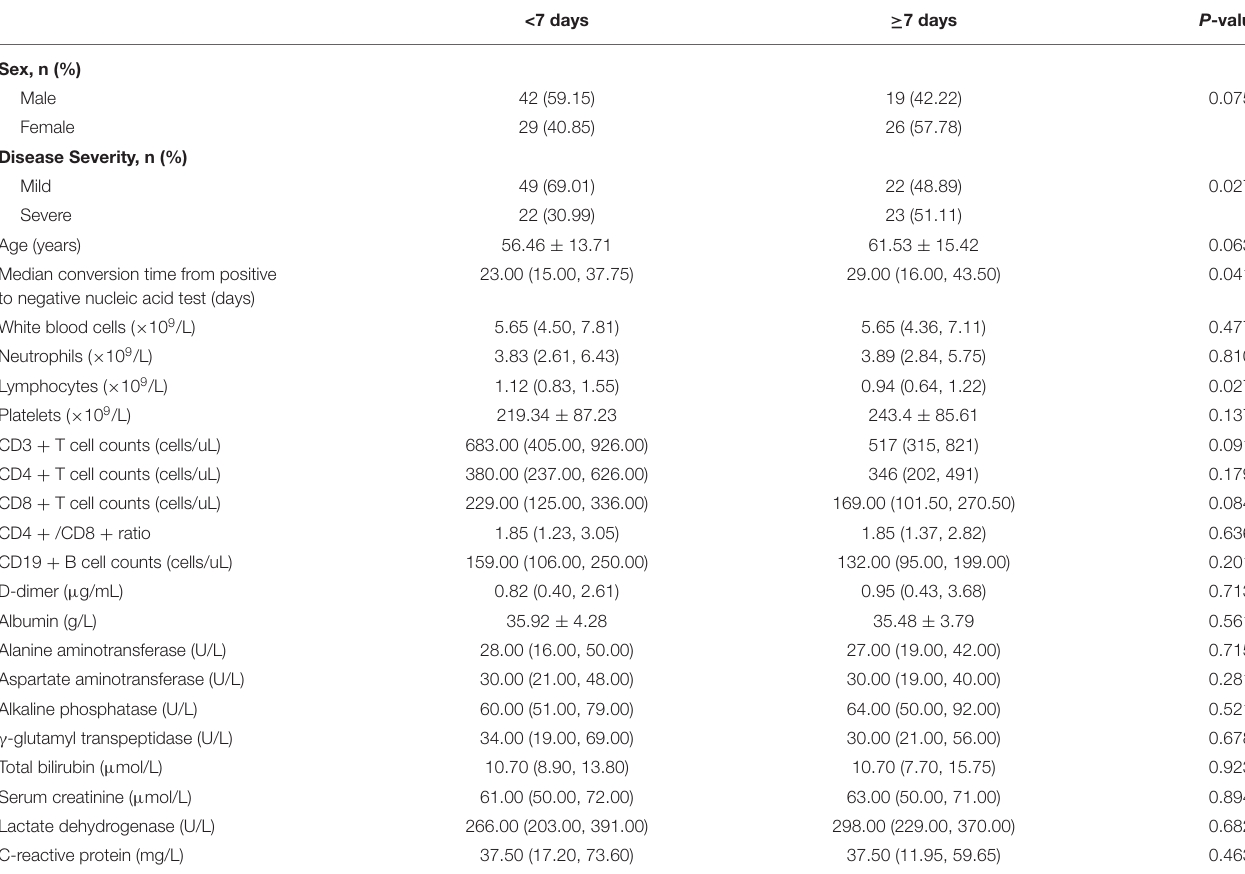
TABLE 1 | Comparison of clinical characteristics and laboratory findings between the two